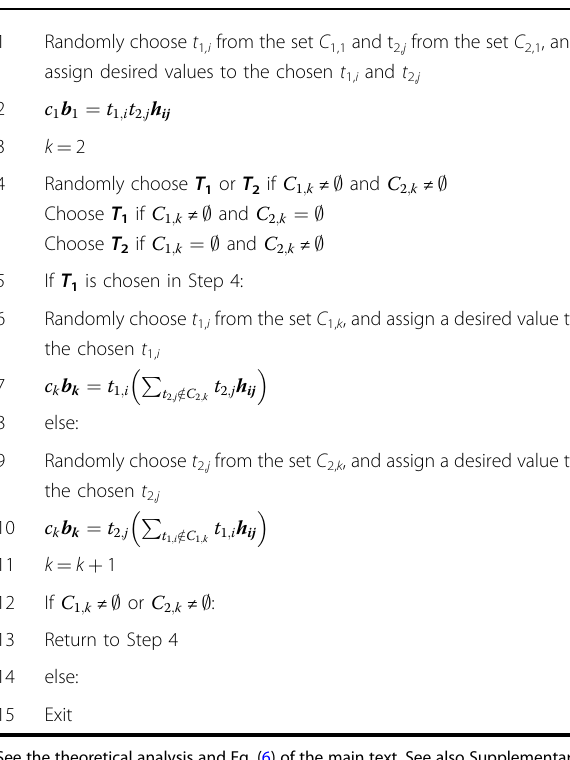
algorithm pseudocode for an optical network that has two diffractive